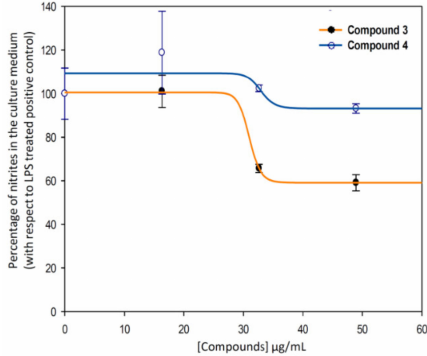
Figure 9. Sigmoidal curves of the e ff ect of the compounds 3 (blue) and 4 (ind, orange) on the release of nitrites in RAW 264.7 macrophage murine cells. Clearly, the curves corresponding to metal-complex compound ( 3 , EC50 NO = 28.76 ± 4.23 µ g / mL) are below to the ligand one ( 4 , EC50 NO = 35.92 ± 0.97 µ g / mL). The data represent the mean ± S.D. of at least two independent experiments performed in